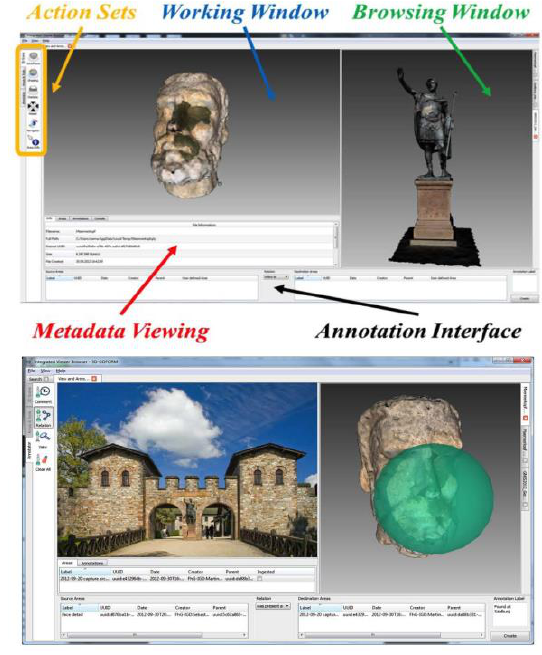
Figure 2: General Graphical User Interface of our semantic enrichment tool dived by 5 different sections - relation annotation between Maennerkopf bust and the Saalburg fort, represented by an image of its main